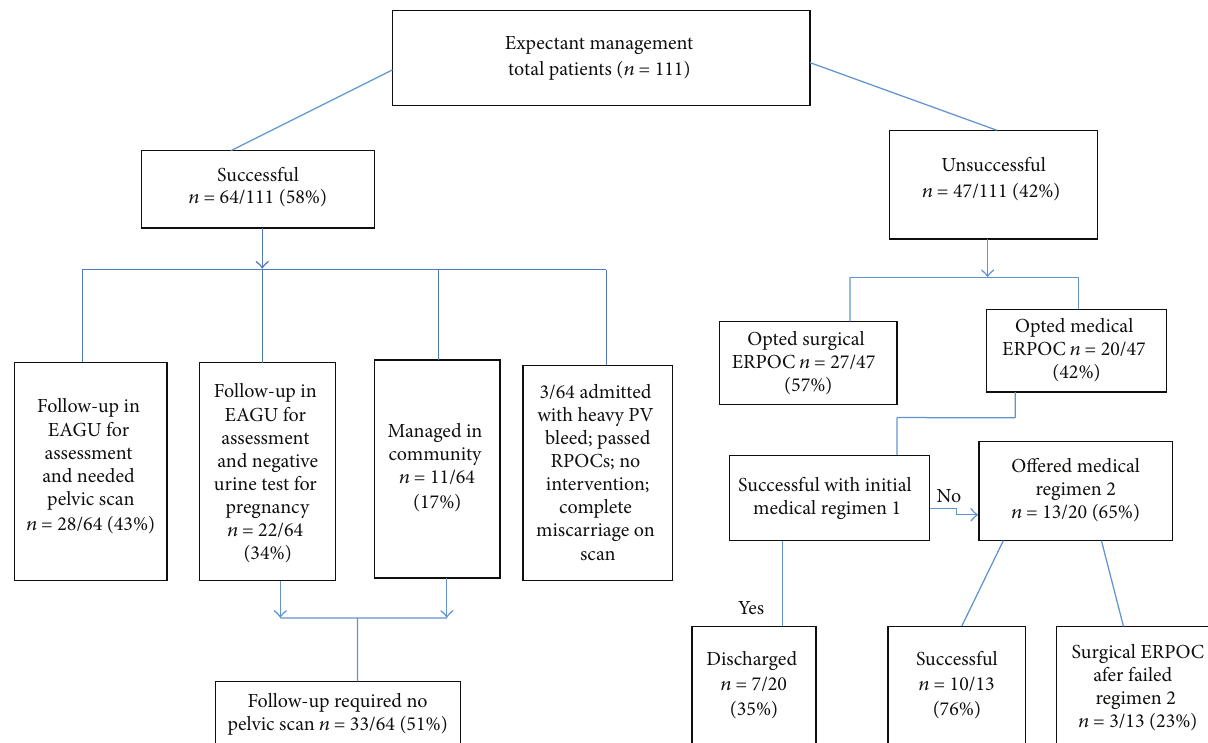
Figure 1: Result summary. Regimen 1: misoprostol loading dose of 800 mcg followed by 400 mcg per vagina after 6 hours. Regimen 2: further three doses of 400mcg misoprostol (3 hours apart) per vagina if there is no response to regimen 1.